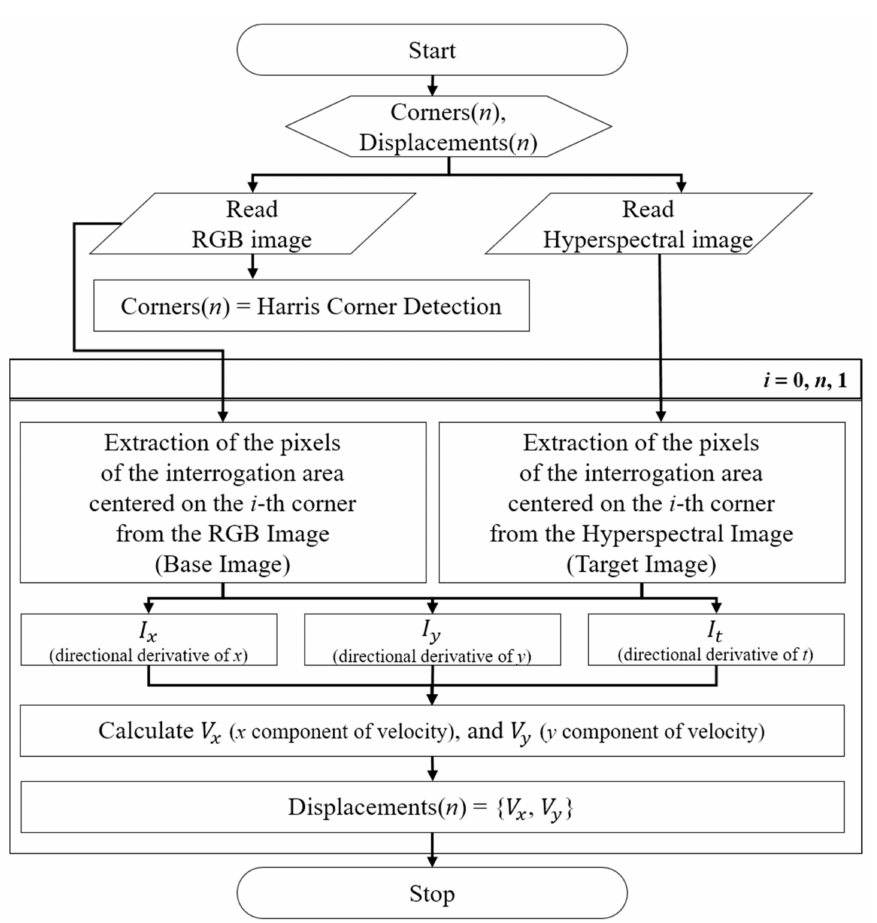
Figure 5. Process flow of the optical flow